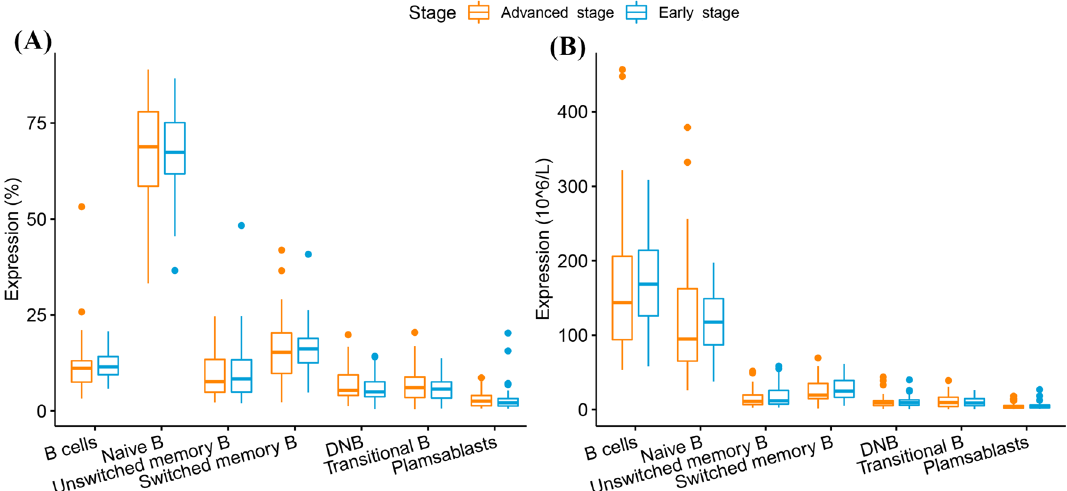
Figure 4. Differences in B lymphocyte subsets between the early- and advanced-stage groups. ( A ) Proportions of B lymphocyte subsets. ( B ) Absolute counts of B lymphocyte